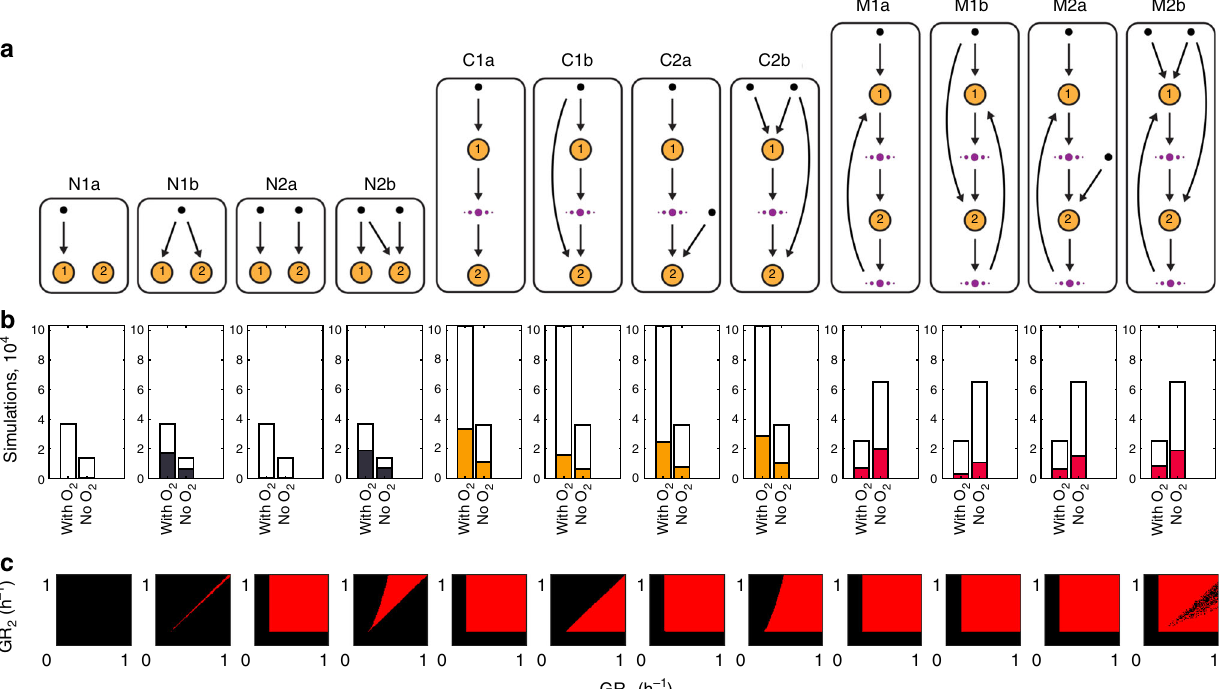
Fig. 7 Interaction motif analysis and dynamical modeling of motif stability. a Schematic representation of speci fi c motif types. Motifs are named according to three features: the interaction type (non-interacting, N; commensal, C; mutualistic, M), the number of carbon sources consumed by the pair (1 – 2), and competition for a primary carbon source (no competition, a; competition, b). Orange circles denote organisms, black dots denote primary carbon sources, and violet dots indicate any arbitrary number of costlessly shared metabolites. Arrows indicate direction of metabolite fl ow. b Frequency of speci fi c motif types. Height of empty white bars indicate the total number of simulations that exhibited the general motif type (non-interacting, commensal, mutualistic). Colored bars within indicate the number of the speci fi c motif type (N1a, N1b, and so on). c Stability space of motifs from dynamical chemostat modeling, as a function of the speci fi c growth rates of the two organisms involved (GR 1 , GR 2 ). Red indicates area of stable